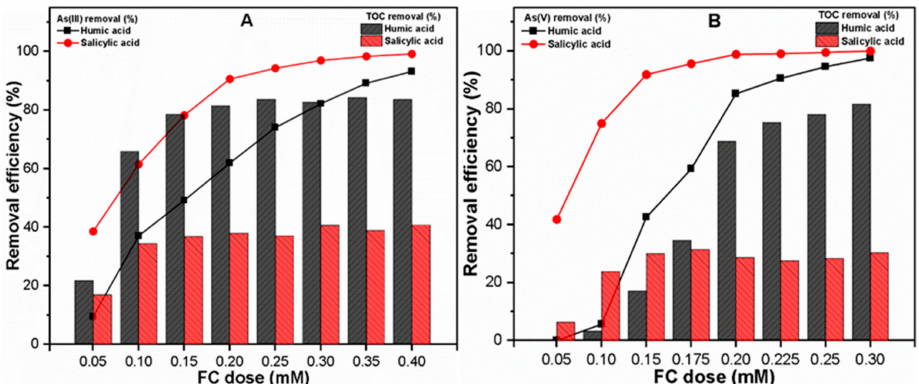
Figure 2. Under various ferric chloride (FC) doses, removal e ffi ciencies of ( A ) As(III) and ( B ) As(V) and respective total organic carbon (TOC) from